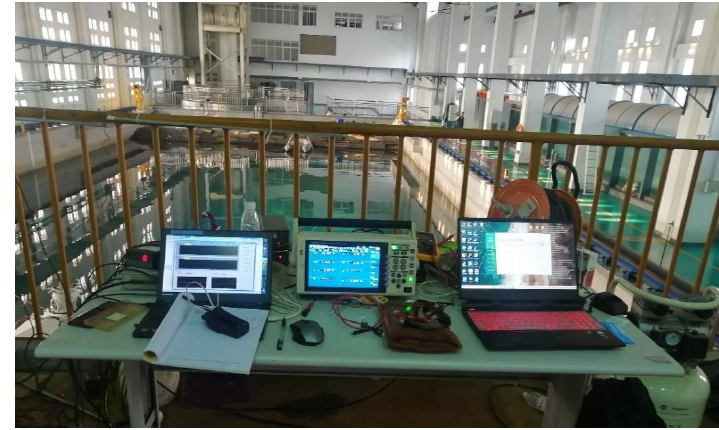
Figure 5. High-precision power analyzer test site.